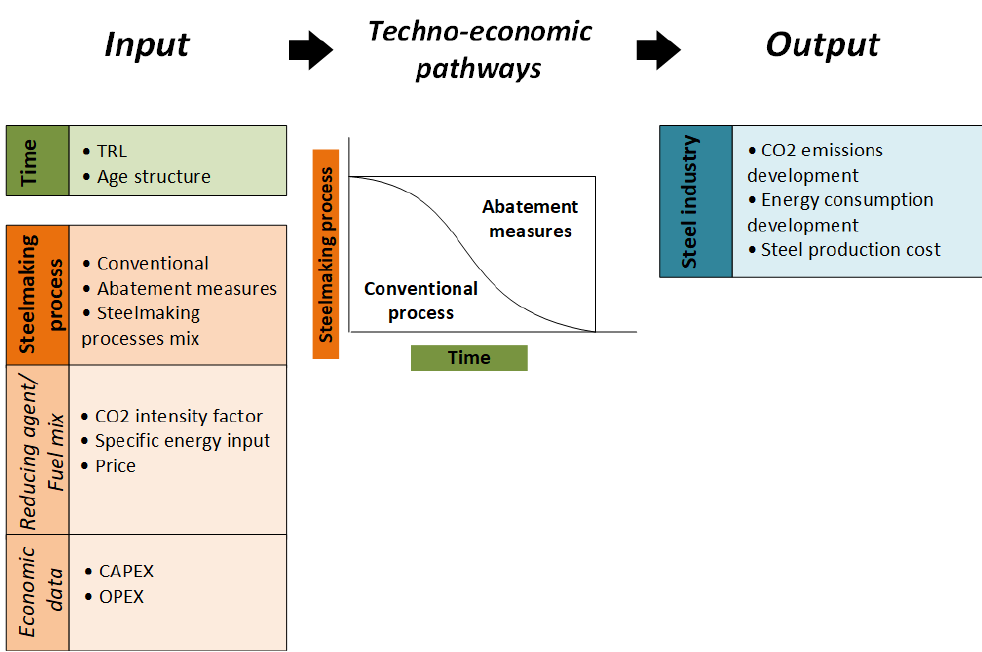
Figure 1. Schematic overview of the techno-economic pathways concept used in this work.